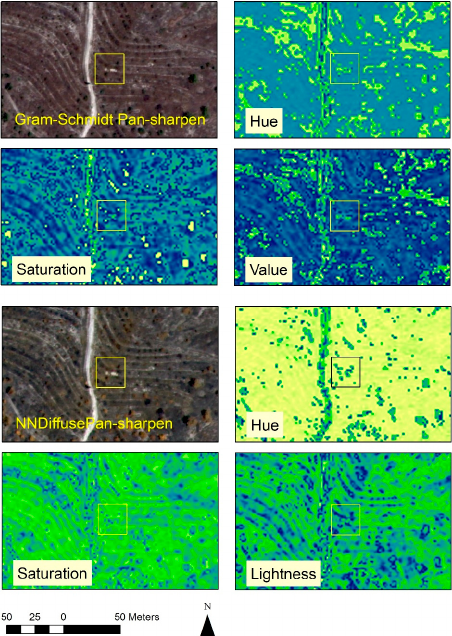
Figure 8. HSV (hue, saturation, and value) and HSL (hue, saturation, and lightness) color transformations of the WorldView-2 image after applying the Gram–Schmidt and NNDiffuse pan-sharpening algorithms. Yellow squares show the looting imprint.